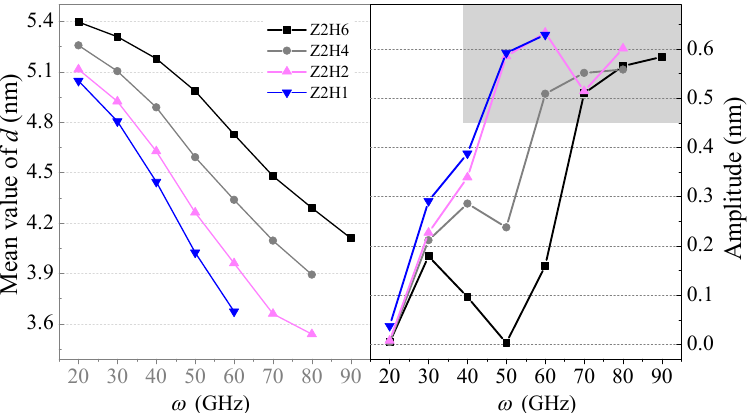
Figure 7. Mean values and amplitudes of the d curves in the systems with different hydrogenation schemes at 8 K between 9 ns and 10 ns.